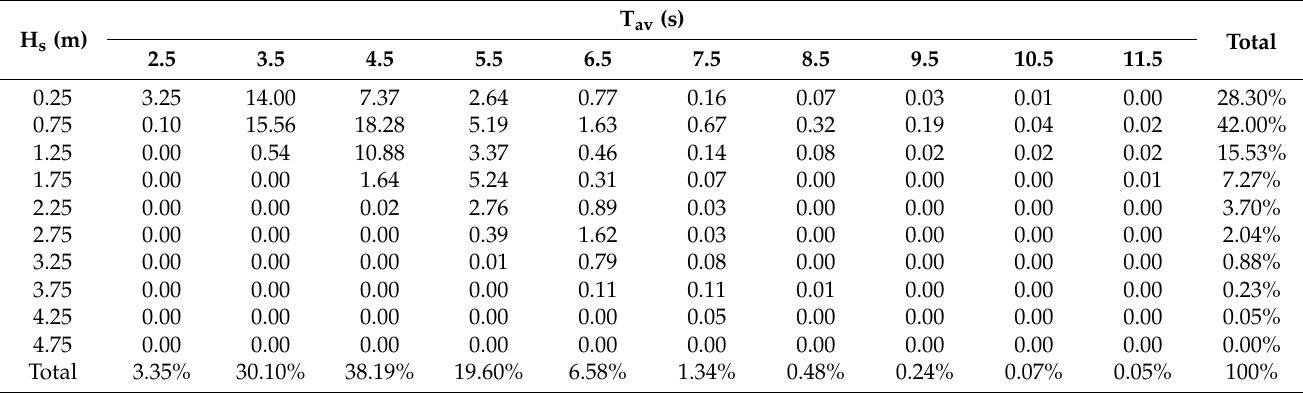
Table 1. The average probability of occurrences of significant wave height and average wave period from 2011 to